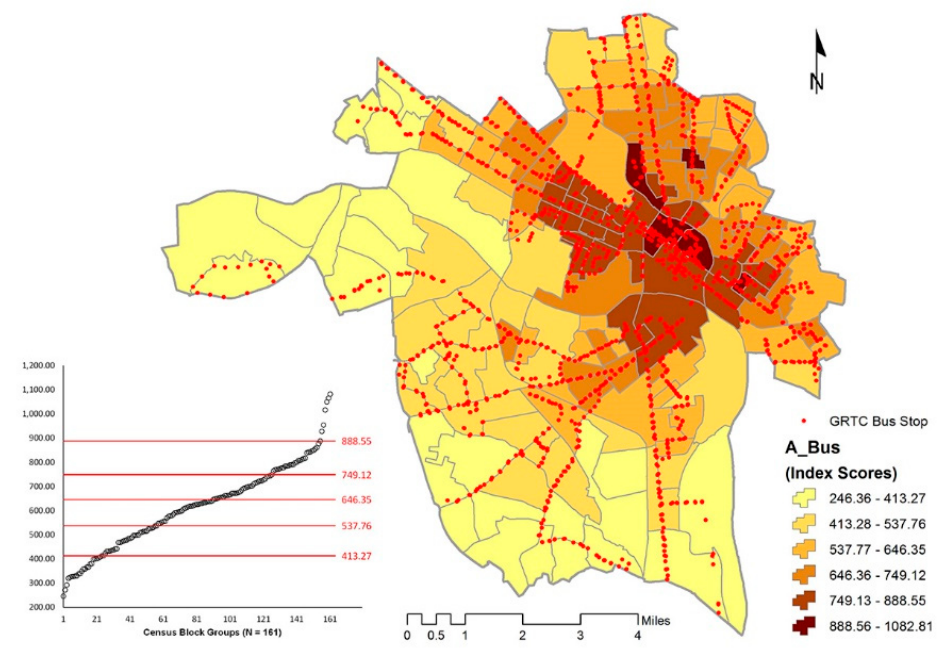
Figure 10. Accessibility to public transportation of Census Block Groups in the City of Richmond.